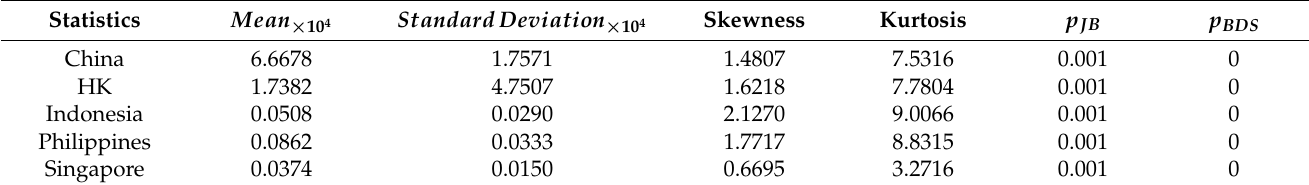
Table 1. Descriptive statistics and statistical tests for tourist arrivals from different countries or